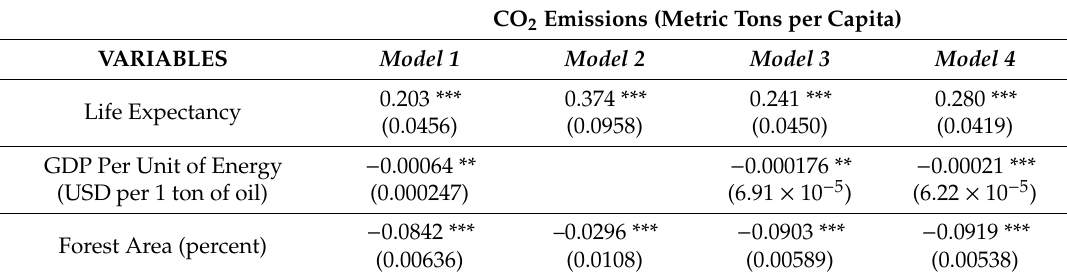
Table 2. The random-e ff ects generalized least squares (GLS) regression of CO 2 emissions (metric tons per capita) for the panel of 10 countries during 1996 −